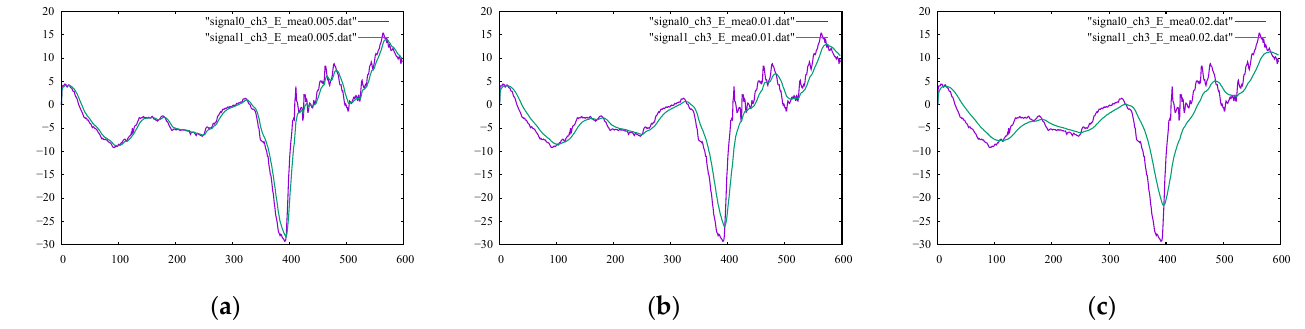
Figure 11. Original noisy motion signal from channel 3 of the root-joint of the kicking character versus the smoothed signal via the Kalman filter using ( a ) 𝐸 (cid:3040)(cid:3032)(cid:3028) = 0.005, ( b ) 𝐸 (cid:3040)(cid:3032)(cid:3028) = 0.01 and ( c ) 𝐸 (cid:3040)(cid:3032)(cid:3028) = 0.02.